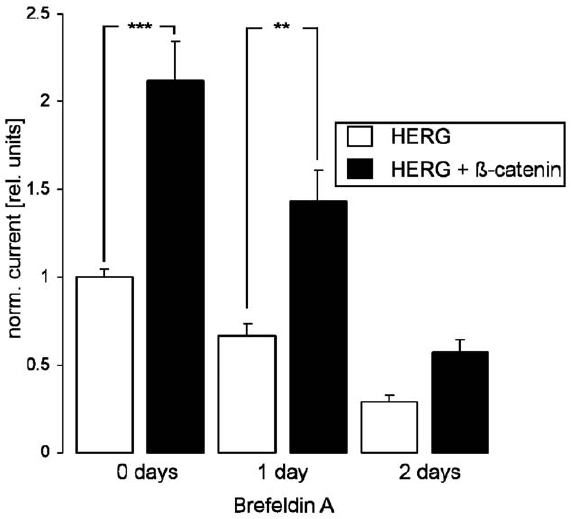
Figure 4. The effect of Brefeldin A on ß-catenin-stimulated HERG currents. Arithmetic means 6 SEM (n=15–19) of the normalized outward tail current following depolarization to + 80 mV recorded in oocytes injected with cRNA encoding HERG (white bars) or with cRNA encoding HERG and ß-catenin (black bars), prior to (0 days) and following incubation for 24 hours (1 day) or 48 hours (2 days) with 5 m M Brefeldin A prior to the measurement. **, ***indicate statistical significance (p , 0.01, p , 0.001) from the absence of ß-catenin cRNA.